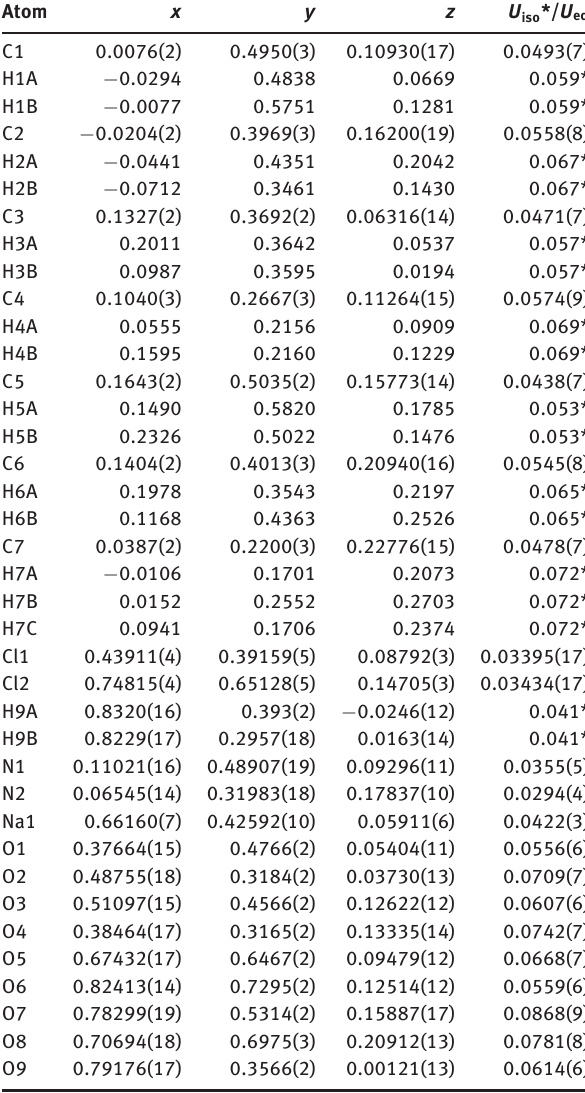
Table 2: Fractional atomic coordinates and isotropic or equivalent isotropic displacement parameters (Å 2